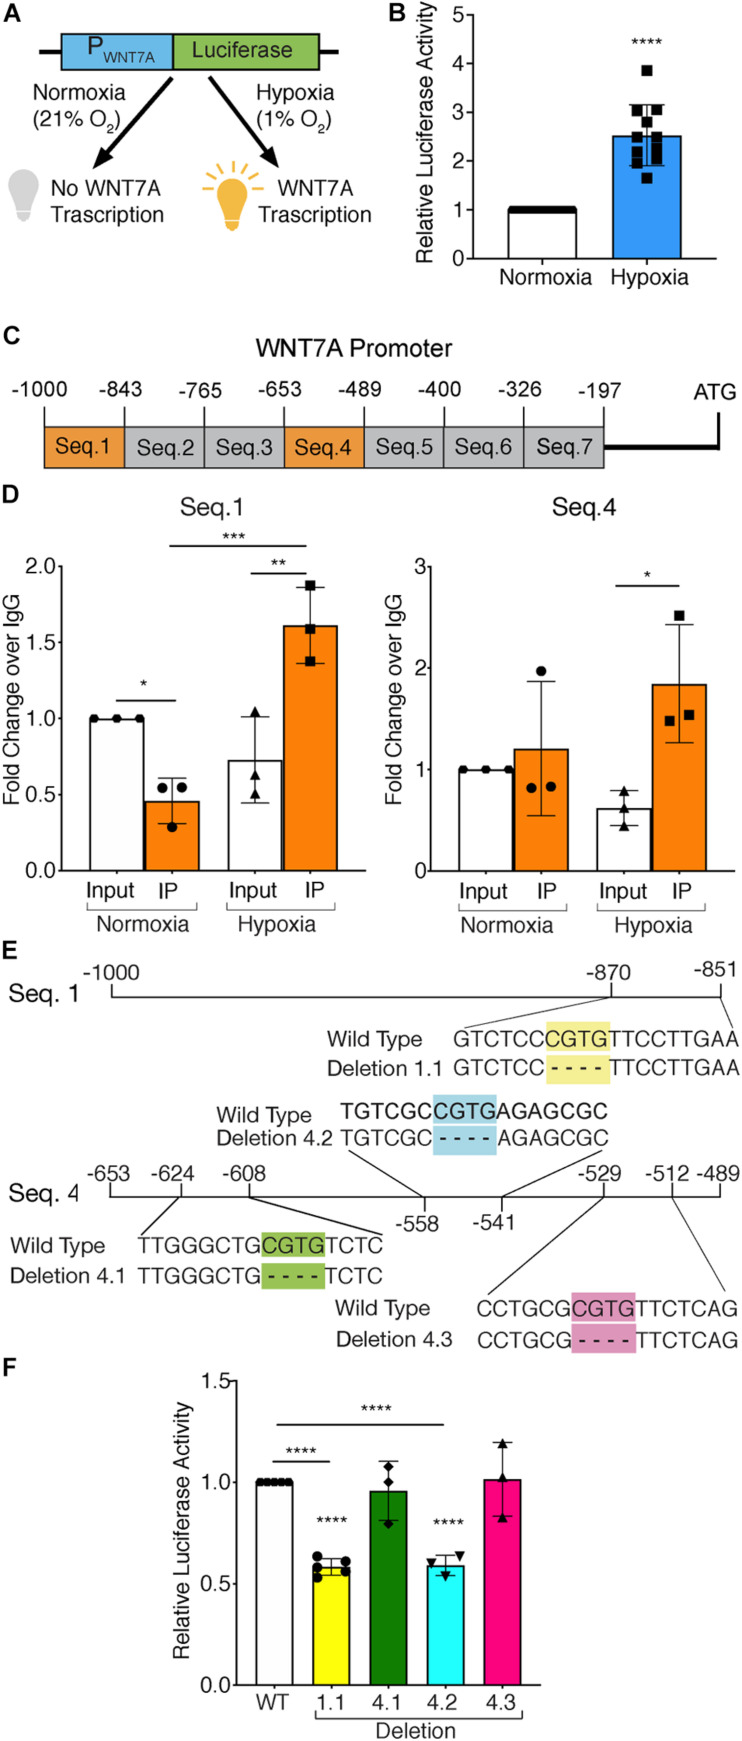
Assessment of hypoxia inducible factor-1α (HIF-1α) binding to the WNT7A promoter after 24h at 1% O2. (A) Schematic representation of pNL1.1 plasmid containing the WNT7A promoter upstream of the luciferase gene reporter. Under normoxia, HIF-1α is degraded and cannot bind the HRE sequences on the WNT7A promoter, inhibiting the luminescence signal; under hypoxia, HIF-1α is stabilized and can bind the WNT7A promoter, inducing the expression of the luciferase gene. (B) Quantification of pNL1.1-WNT7A promoter activity by luciferase assay in murine myoblasts under normoxia and hypoxia (1% O2; n = 11). (C) Schematic representation of the seven binding sequences designed within the WNT7A promoter and used for qPCR analysis after chromatin immunoprecipitation (ChiP). (D) qPCR analysis of HIF-1α binding on Seq.1 and Seq.4 of the WNT7A promoter (n = 3). (E) Schematic representation of the deletions of the HRE binding sequences identified in Seq. 1 (Deletion 1.1) and Seq. 4 (Deletion 4.1, 4.2, and 4.3) inserted in the pNL1.1-WNT7A promoter construct using site-directed mutagenesis experiments. (F) Quantification of mutated pNL1.1-WNT7A promoter activity by luciferase assay (n = 5 for mutation 1.1, n = 3 for mutation 4.1, 4.2 and 4.3). Data information: all data represent mean ± SD. *p < 0.05, **p < 0.01, ***p < 0.001, ****p < 0.0001 (Ordinary one-way ANOVA).